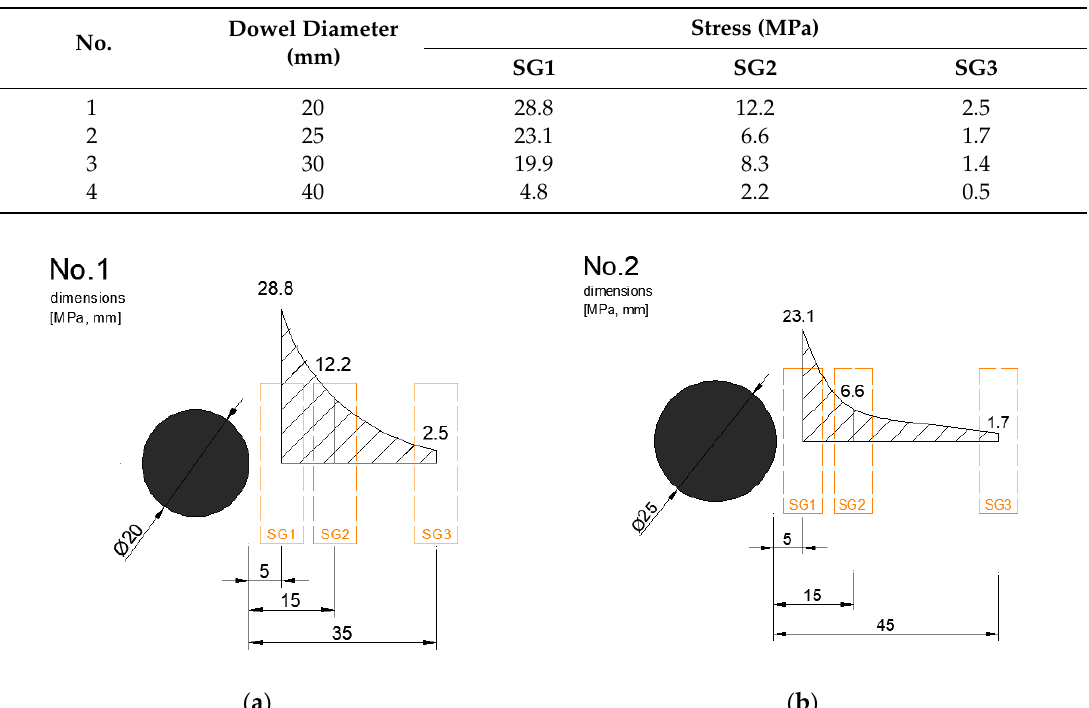
Table 5. Stress distribution at faces of concrete beams, force 10 kN.